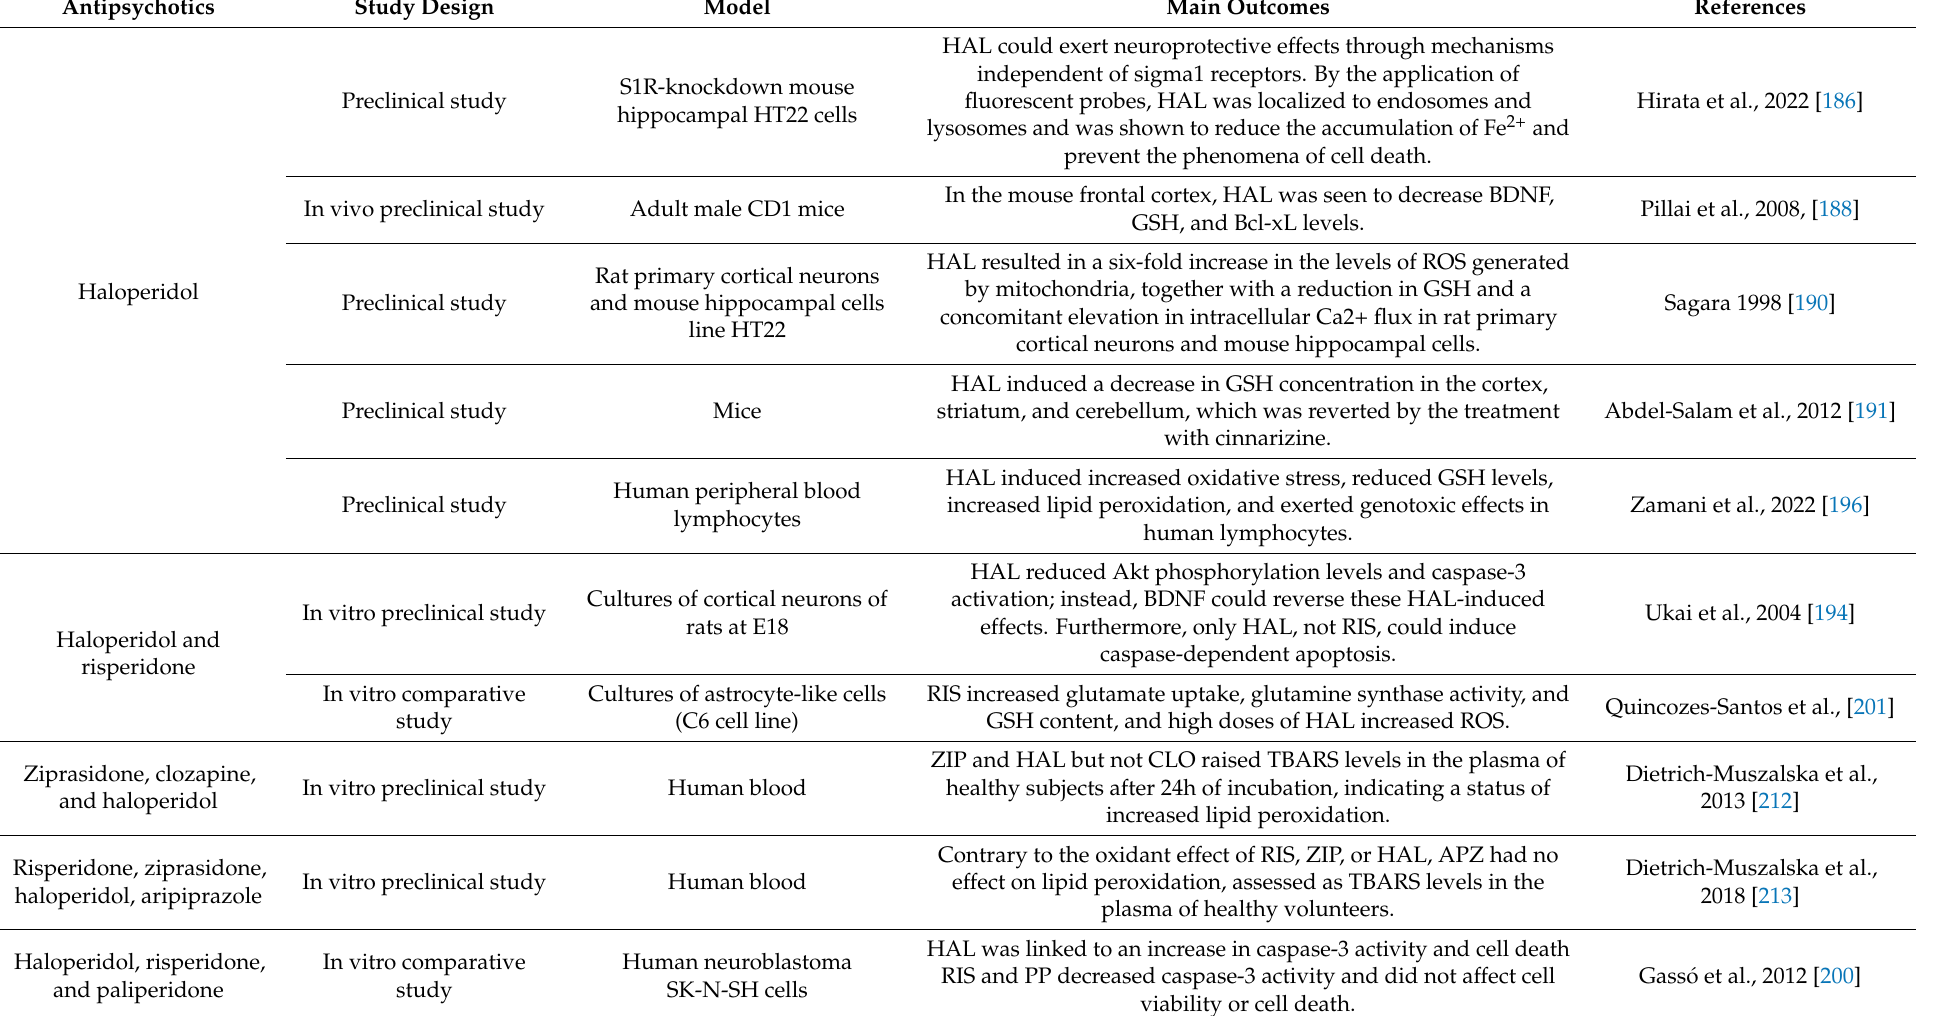
Table 1. Oxidant and antioxidant effects of first- and second-generation